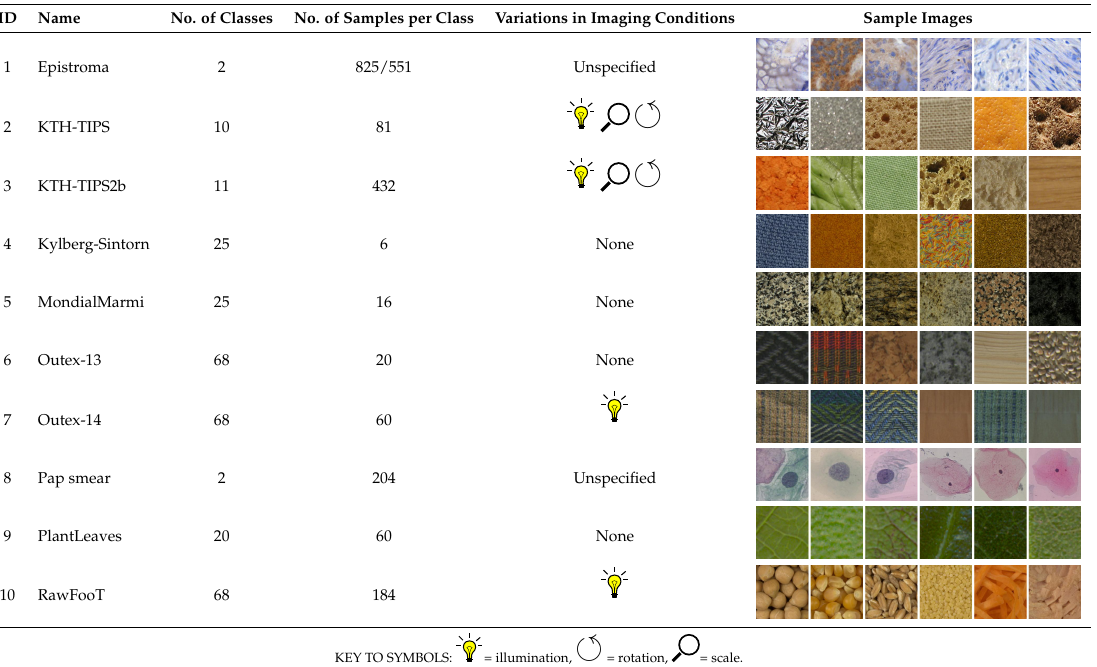
Table 1. Datasets used in the experiments: round-up